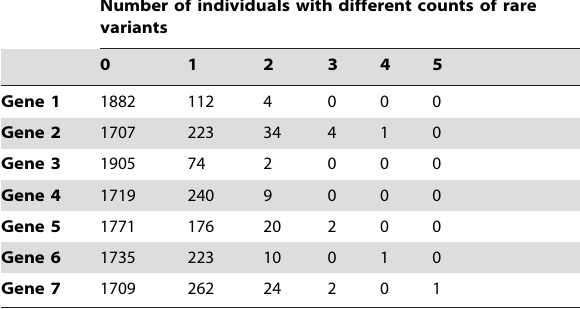
Table 3. Description of the count of rare variants per